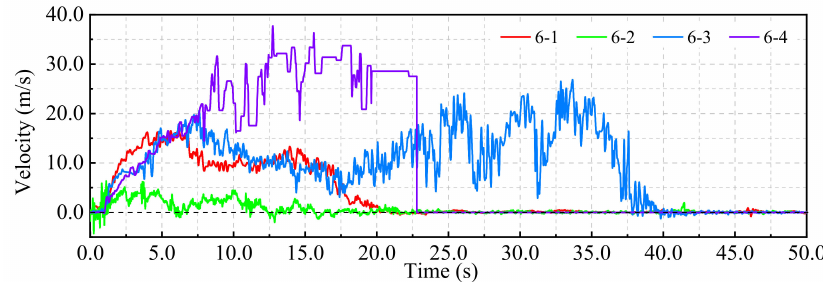
Figure 16. Velocity time history curves of some rock stones on the rockfill slope.